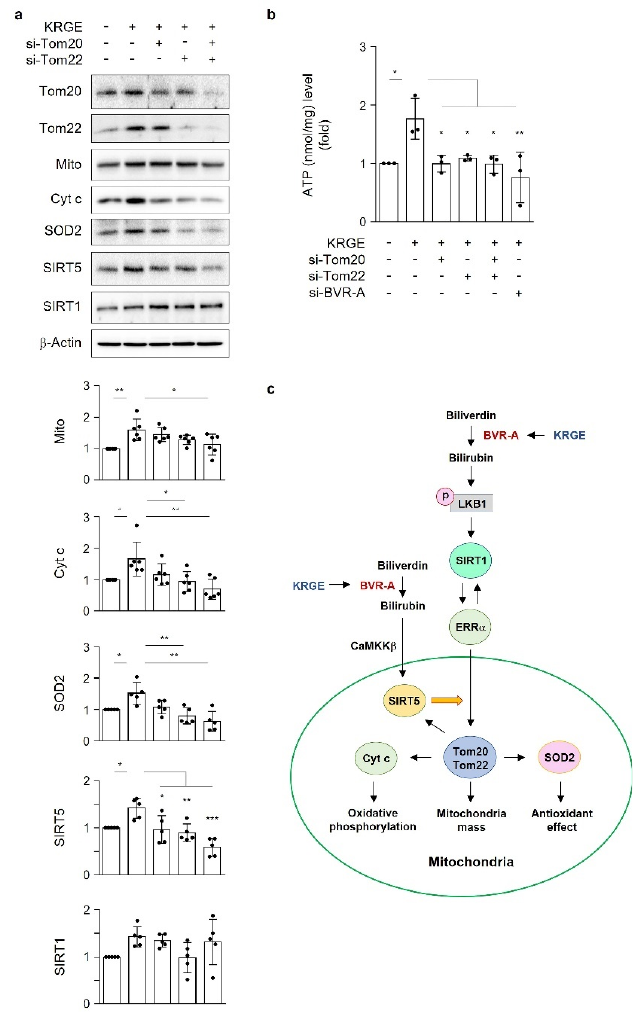
Figure 7. KRGE induces the expression of mitochondrial functional proteins in astrocytes via Tom20/Tom22. ( a ) Astrocytes were transfected with control or the indicated siRNAs. Target protein levels were detected via Western blotting, and the protein levels were quantified ( n = 5–6). ( b ) As- trocytes were transfected with control or the indicated siRNAs. ATP levels (nmol/mg) were detected